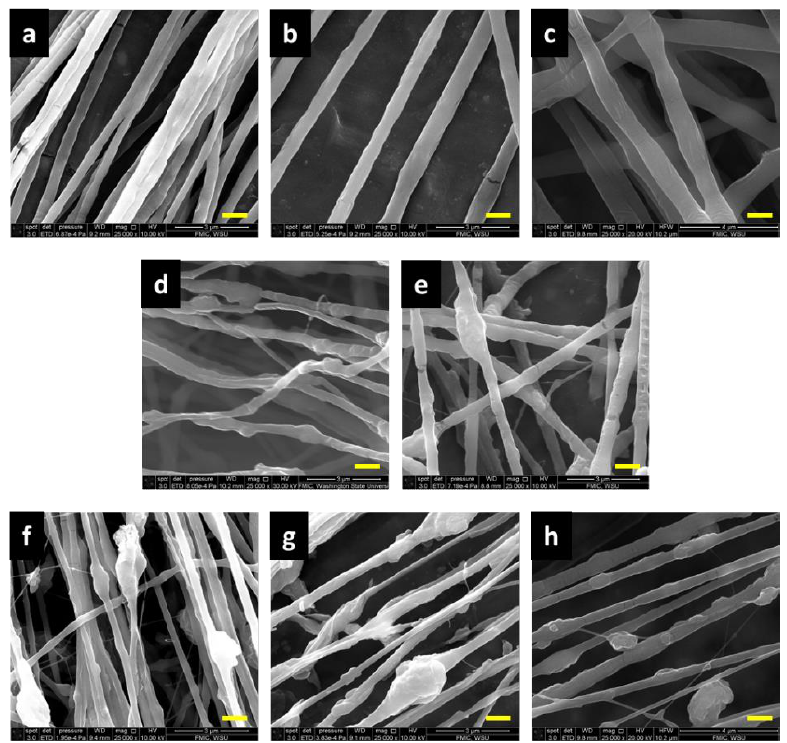
Figure 2. Scanning electron microscopy (SEM) images of fibers produced from solutions of pure PEO ( a : 3%; b : 4%; c : 5%), blended PEO-PANI ( d : 3%-2.5%; e : 4%-2.5%), and side-by-side PEO-PANI ( f : 3% - 2.5%; g : 4%-2.5%; h : 5% -2.5%). (Scale bar: 1 µm) (Magnification: 25000×).